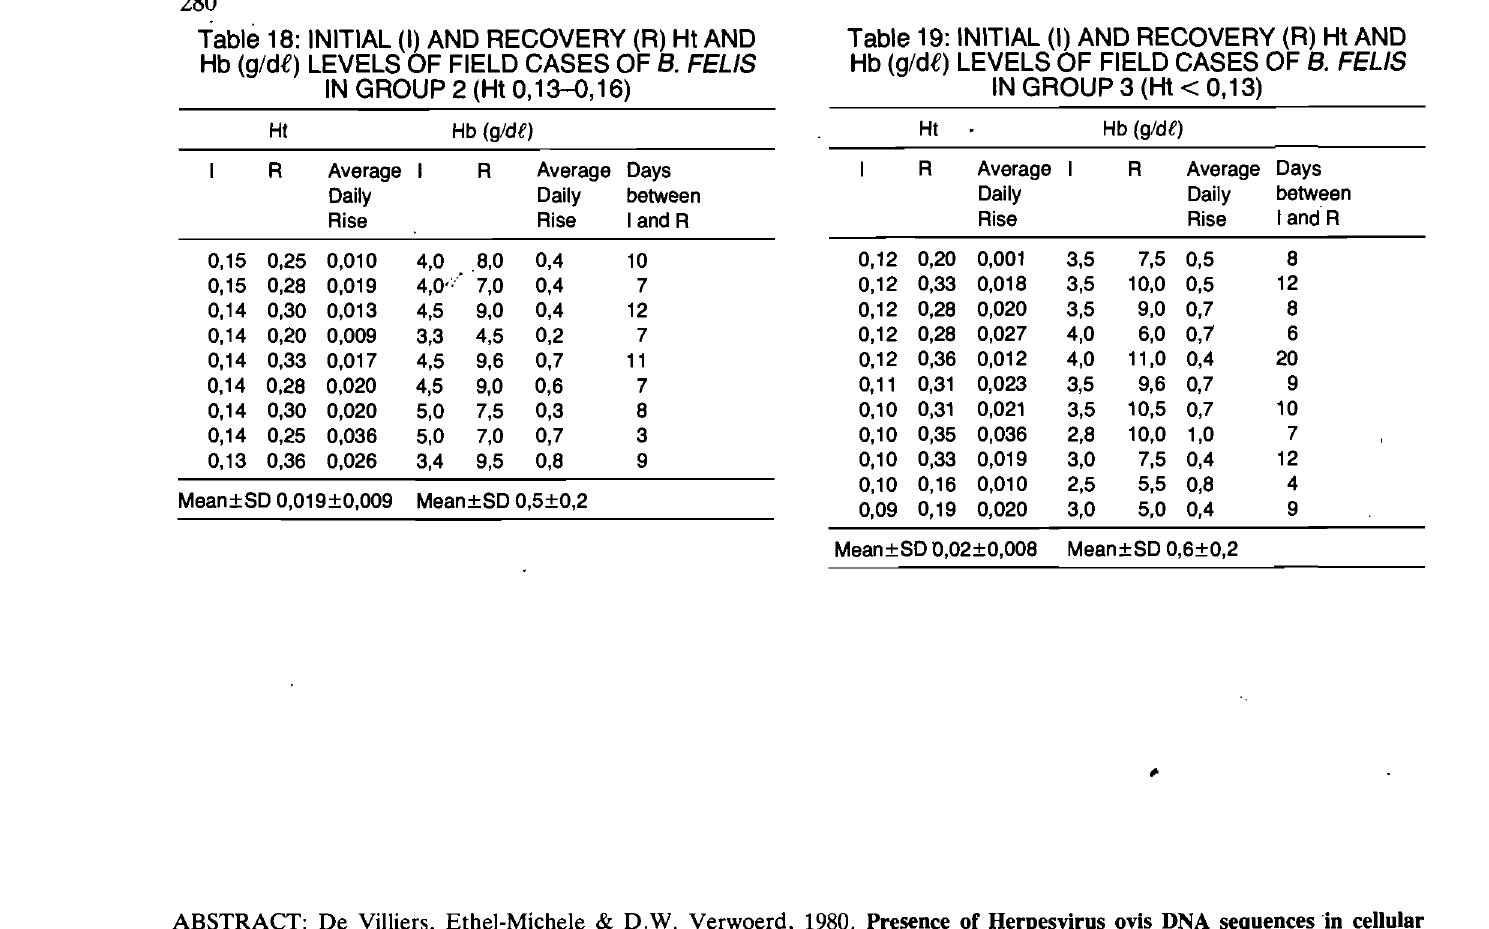
Table 18: INITIAL (I) AND RECOVERY (R) Ht AND Table 19: INITIAL (I) AND RECOVERY (R) Ht AND Hb (g/dC) LEVELS OF FIELD CASES OF B. FELIS Hb (g/dC) LEVELS OF FIELD CASES OF B.